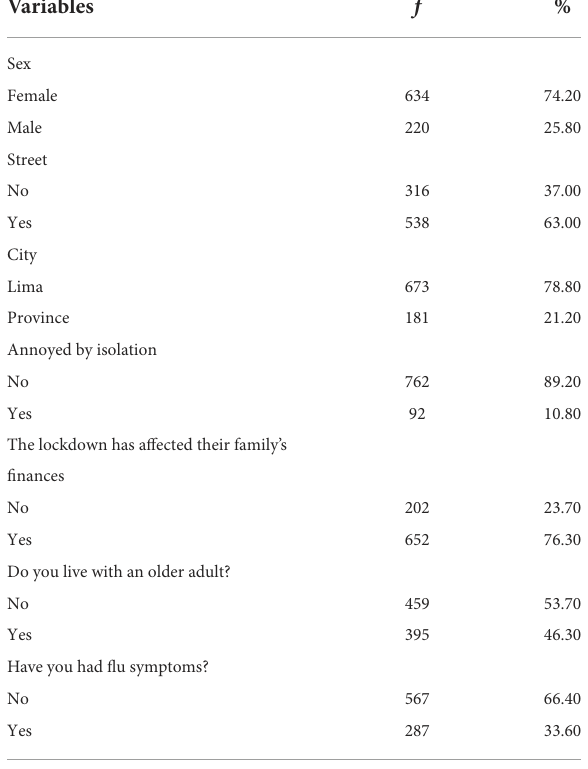
TABLE 1 Sociodemographic